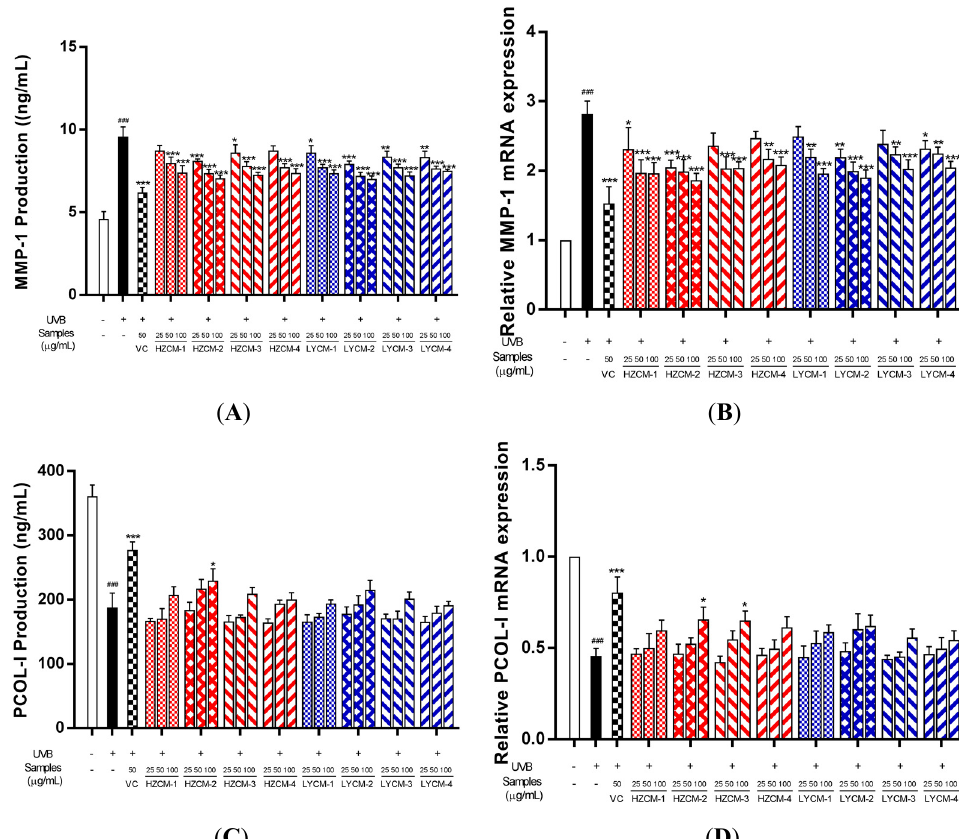
Figure 4. Ex vivo anti-aging effects of Cortex Moutan extracts. Effects of Cortex Moutan (CM) extracts on the production of MMP-1 ( A ), the relative expression of MMP-1 mRNA ( B ), the production of PCOL-I ( C ), the relative expression of PCOL-I mRNA ( D ). Vitamin C: VC; HZCM-1, HZCM-2, HZCM-3, and HZCM-4: CM collected in Heze in March, June, September, and December, respectively. LYCM-1, LYCM-2, LYCM-3, and LYCM-4: CM collected in Luoyang in March, June, September, and December, respectively. The levels of MMP-1 and PCOL-I were measured by enzyme-linked immunosorbent assay (ELISA) kits. MMP-1 and PCOL-I mRNA expressions were examined by RT-PCR. The concentration of VC was 50 μ g/mL, and three concentrations of eight CM extracts were 25, 50 and 100 μ g/mL. Data are expressed as mean ± SD ( n = 3). * p < 0.05, ** p < 0.01 and *** p < 0.001 versus the model group with UV irradiation; ### p < 0.001 versus the control group without UVB irradiation.